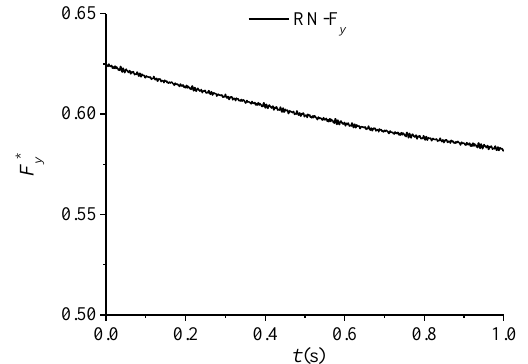
Figure 18. The total axial water thrust of the runner.